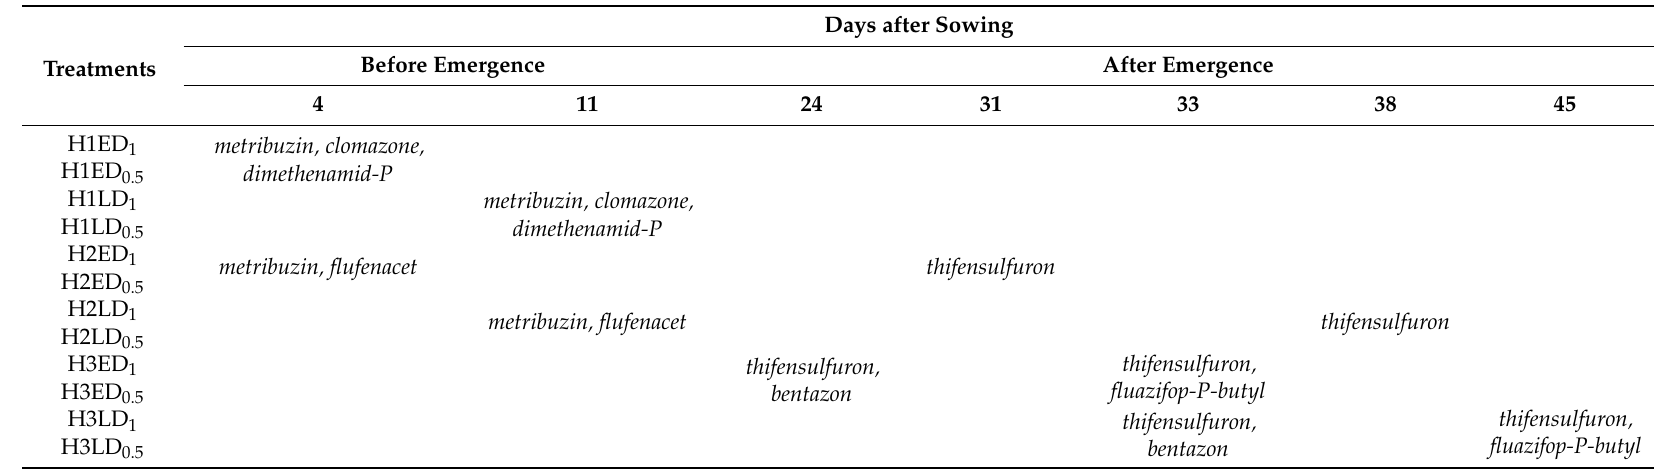
Table 1. The herbicide application times for the greenhouse experiment (in days after sowing of soybeans). H1, herbicide combination 1; H2, herbicide combination